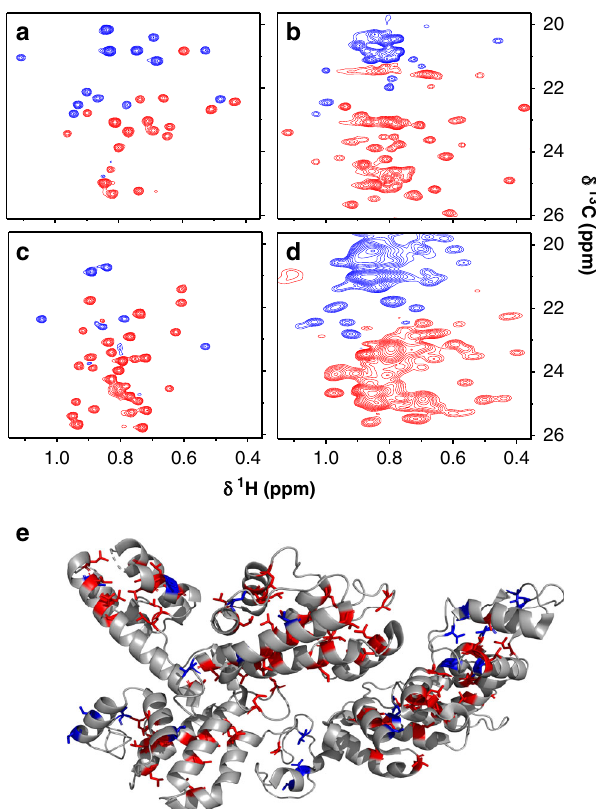
Fig. 4 Application of the valine-selective decoupling pulse on biologically relevant proteins. Constant-time 2D 1 H – 13 C methyl HMQC spectra of four biologically relevant proteins are shown. a Cas9 HNH domain (130 µ M, 15 kDa); b Cas9 REC1-2 domain (250 µ M, 52 kDa); c Human IL2 (920 µ M, 15.4 kDa); d eIF4A (50 µ M, 46 kDa). Unambiguous distinction between the valine (blue) and leucine (red) resonances is achieved. Only Leu – Val overlapping region of the HMQC spectrum is shown here. The full spectra of these proteins are presented in Supplementary Figs. 6 and 7. e Here we show the 3D structure for the REC1-2 domain of Cas9 (PDB ID: 4UN3) 52 where the valine and leucine residues are highlighted in blue and red,